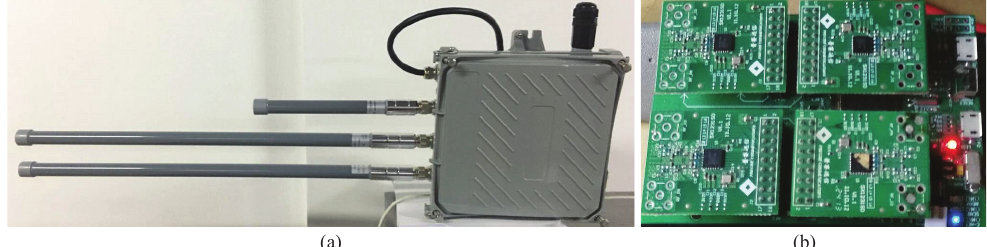
Figure 2. Devices used in experiments; ( a ) multi-radio base station; ( b ) remote multi-radio node.